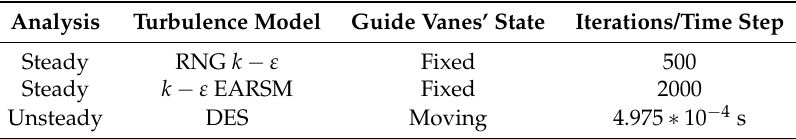
Table 3. Solution strategy adopted for the